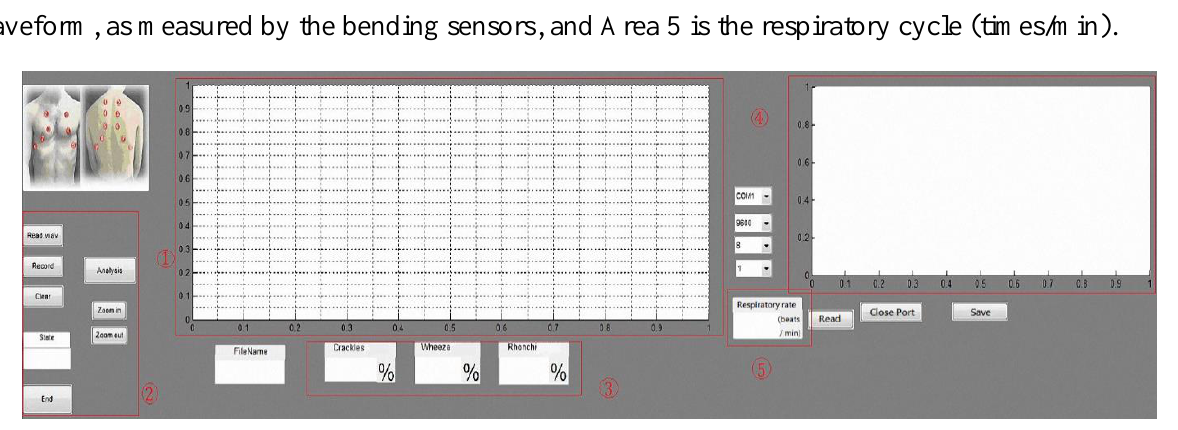
Figure 5. GUI design of the diagnosis